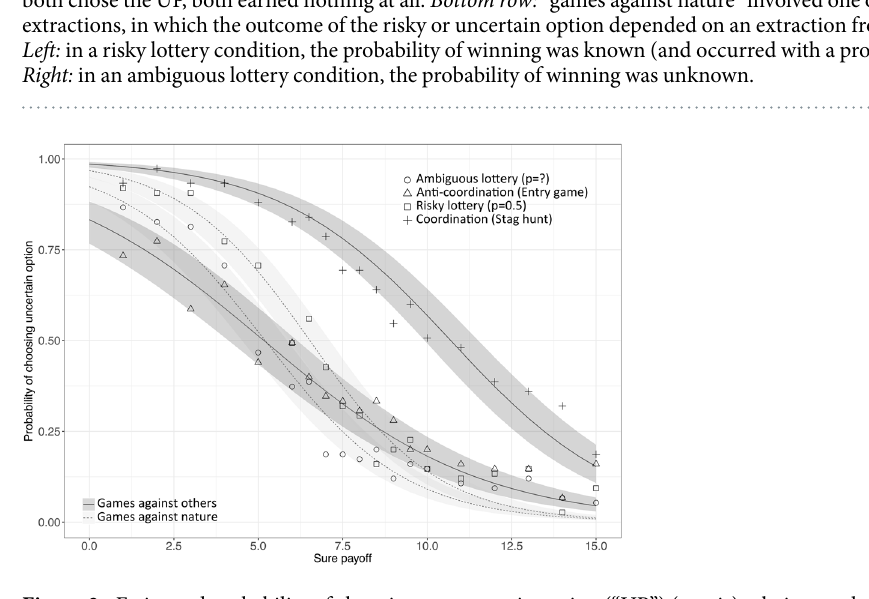
Figure 2. Estimated probability of choosing an uncertain option (“UP”) (y-axis) relative to a lower paying but safer alternative (“SP”) (x-axis) in games against others (darker shades) or games against nature (lighter shades). Symbols represent the raw percentages of UP choices observed in each of the four decision environments, for each SP value: coordination games (i.e., stag hunts, crosses), anti-coordination games (i.e., entry games, triangles), lotteries with risky/known success probability (of p = 0.5, squares), or ambiguous/unknown success probability (circles). Shaded ribbons represent 95% confidence intervals of the estimated fixed